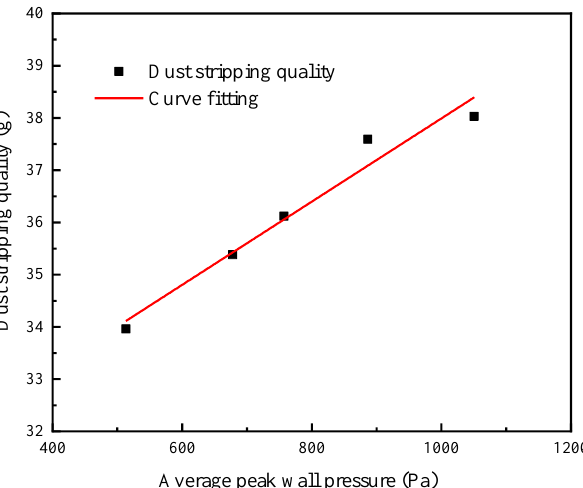
Figure 5. The effect of injection pressure on dust stripping rate (DSR).